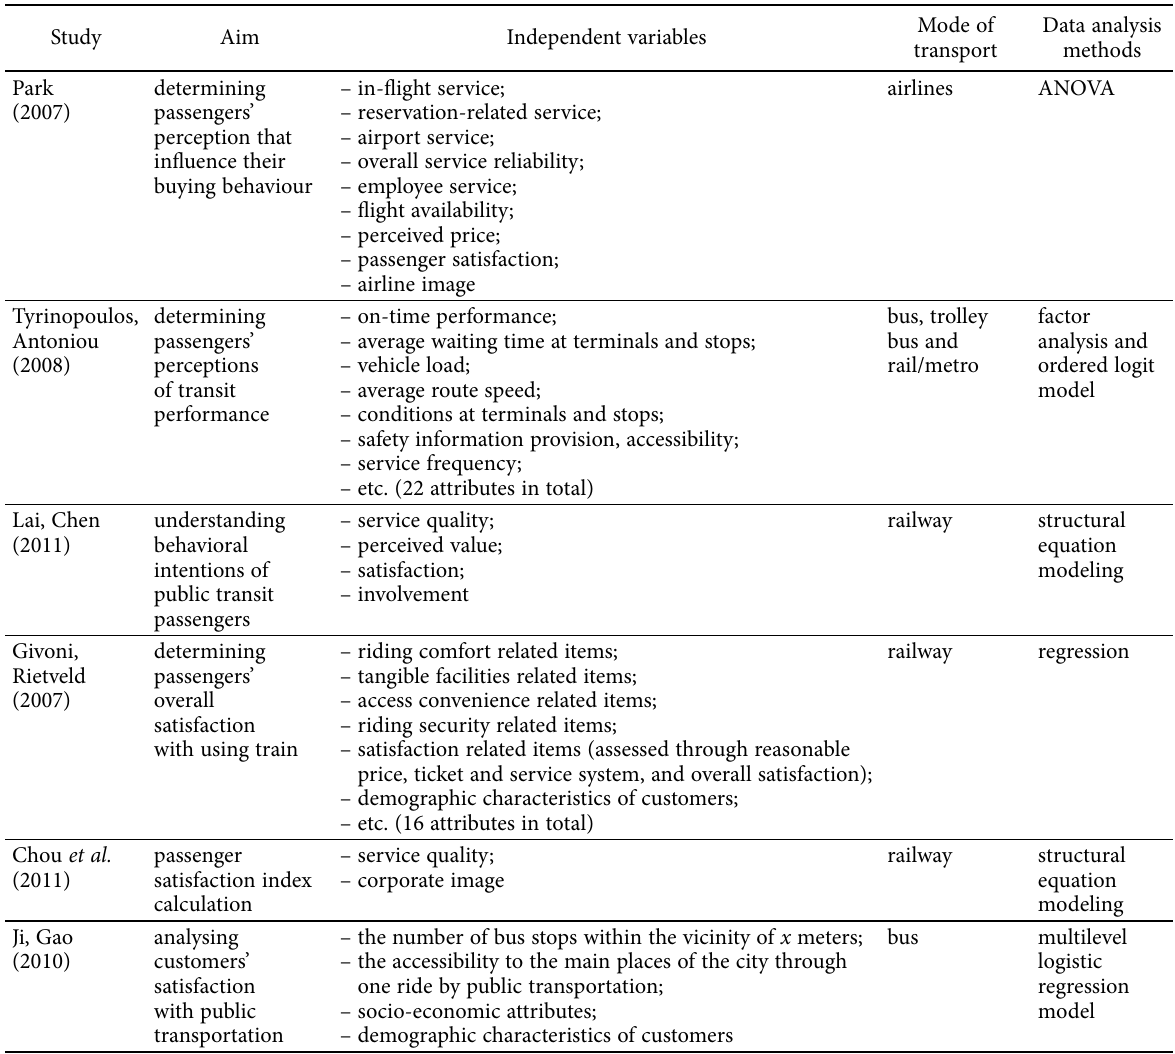
Table 2. Summary of literature review on passenger